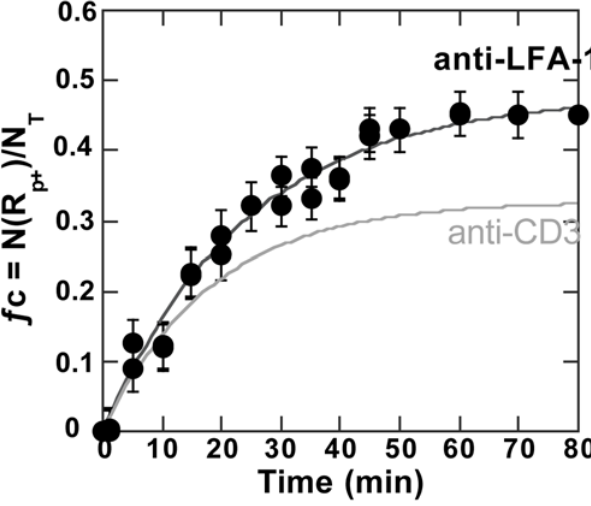
Figure 8. Cell-anti-LFA-1 particle binding kinetics. e c , the ratio of the number of particle-bearing cells (number of events in R p + ) to total number of cells N T is displayed as a function of time. Conditions as in fig. 2 except that particles were grafted here at saturation with anti-LFA- 1 ( N ) ( r L =1.9 6 10 4 / m m 2 ). The curve obtained with anti-CD3 particles was repeated to allow comparison ( –– ).